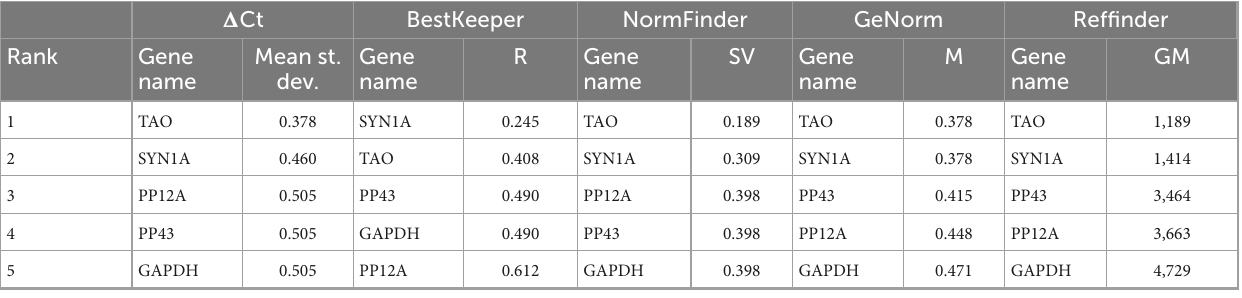
TABLE 3 Ranking of candidate reference genes for various Sitophilus oryzae developmental stages, according to the (cid:49) Ct method, BestKeeper, NormFinder, GeNorm, and Reffinder.